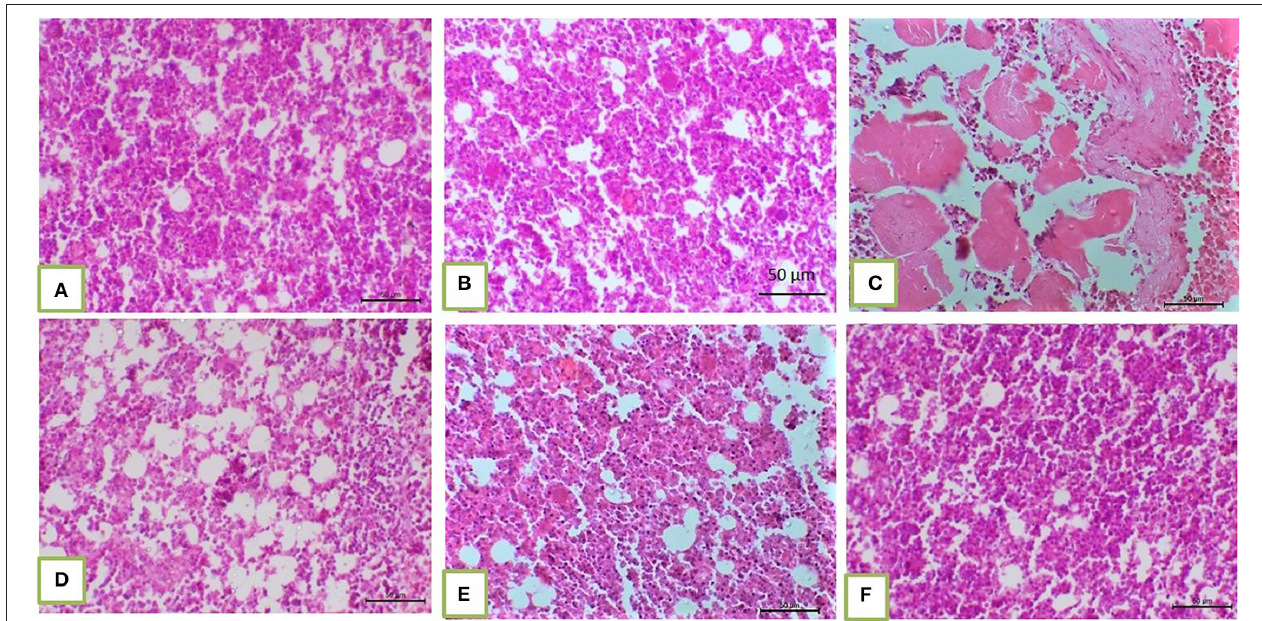
FIGURE 1 | BM biopsy demonstrated normal cellular BM separated from each other by fat vacuoles in corn oil-treated groups and those treated with 100, 200, and 300 mg/kg BW bLf [ (A) and (B) , respectively]. Hypocellular BM with residual islands of hematopoietic cells in the Bz-treated group (C) . Slight increase in BM cellularity